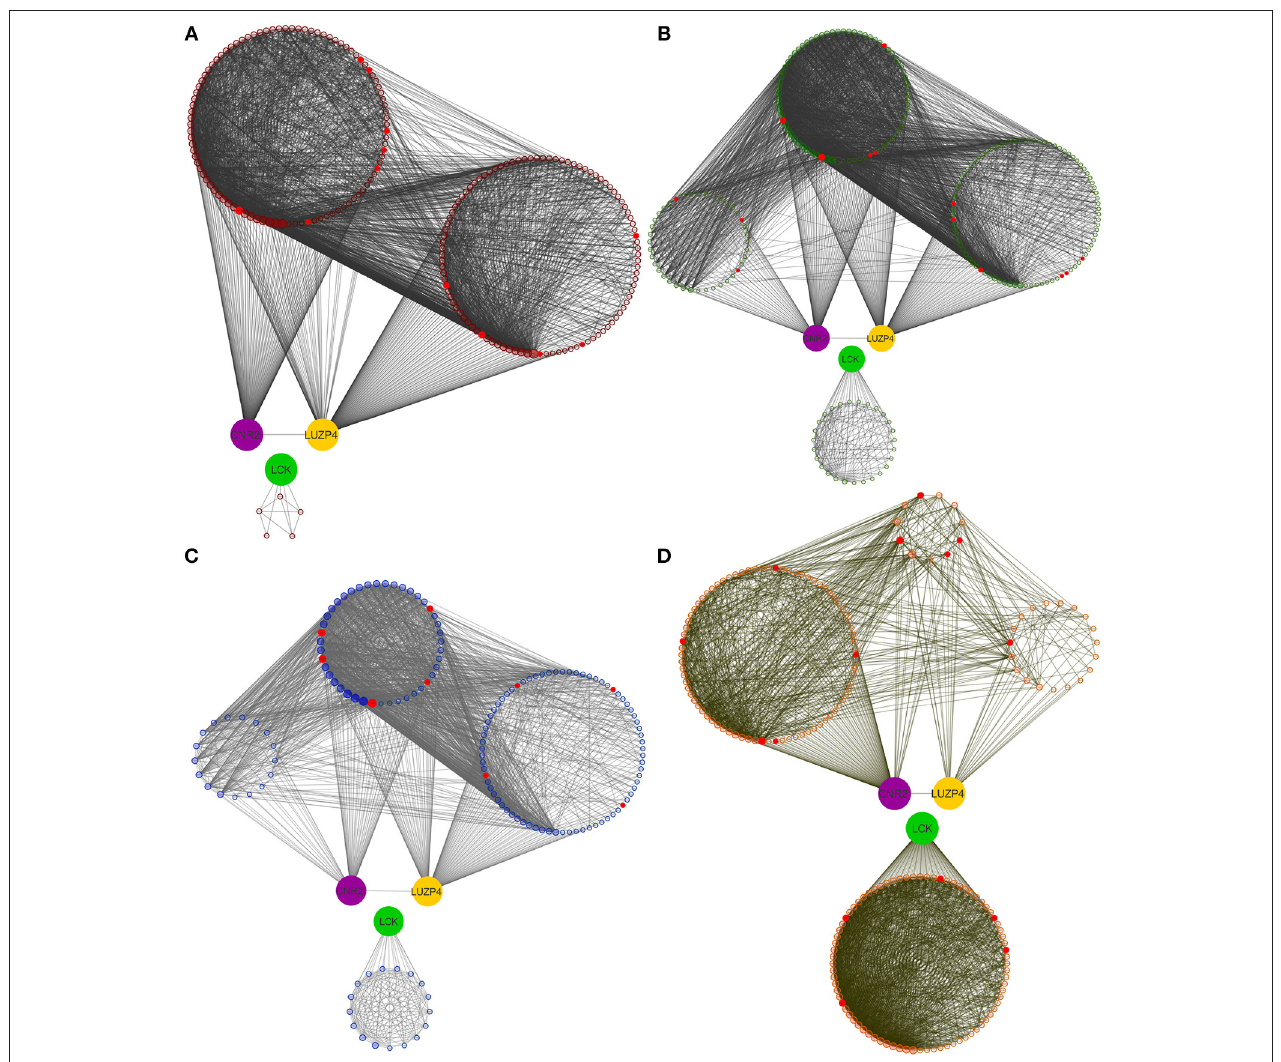
FIGURE 4 | First neighbors of CNR2, LCK, and LUZP4 genes. Genes that are connected to CNR2 (violet), LCK (green) and LUZP4 (yellow) are shown. (A–D) Show the same order than Figures 1 , 2 . It can be seen that CNR2 is highly connected in all subtypes; LCK gene has a high degree relevance in HER2-enriched subtype. Finally, LUZP4 gene has different degree relevance depending on the molecular subtype. It is worth noticing that CNR2 and LUZP4 share first neighbors, but not with